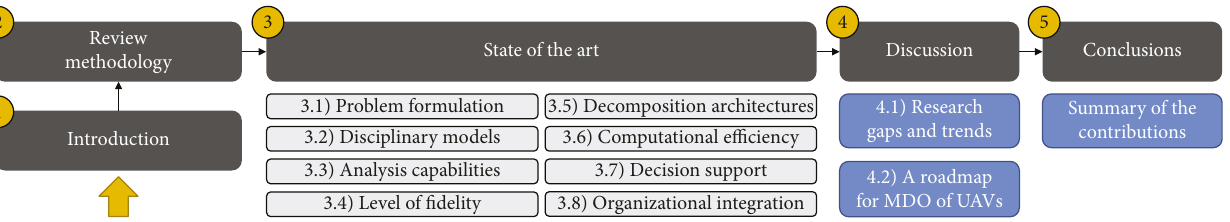
Figure 2: Overview of the structure of the paper and breakdown of the